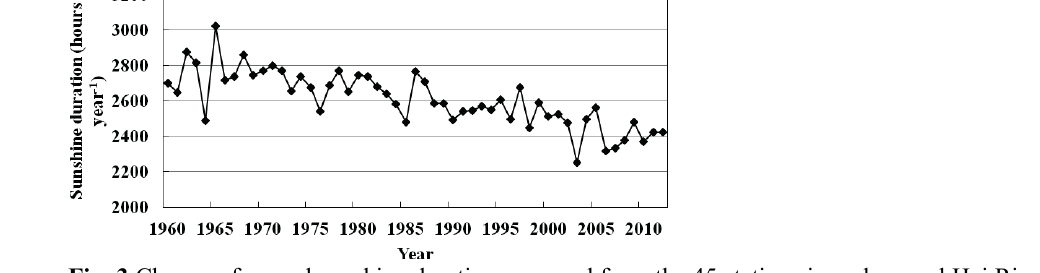
Fig. 3 Change of annual sunshine duration averaged from the 45 stations in and around Hai River basin from 1960 to